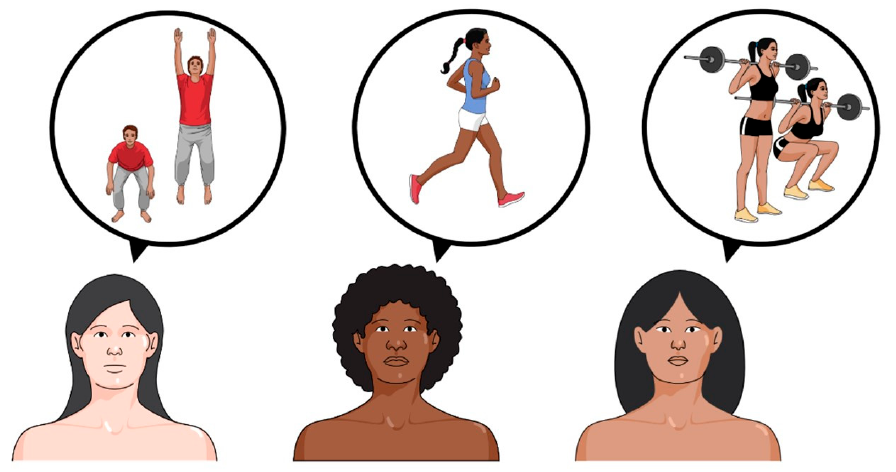
Figure 1. An illustration of the intervention.